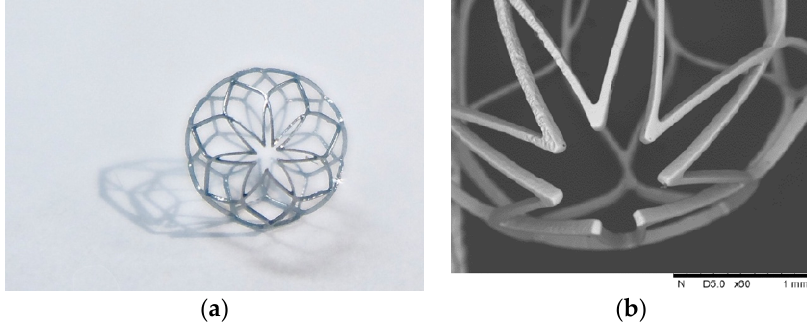
Figure 15. ( a ) First prototype in the world of the spherical occlusion device and ( b ) its SEM image.